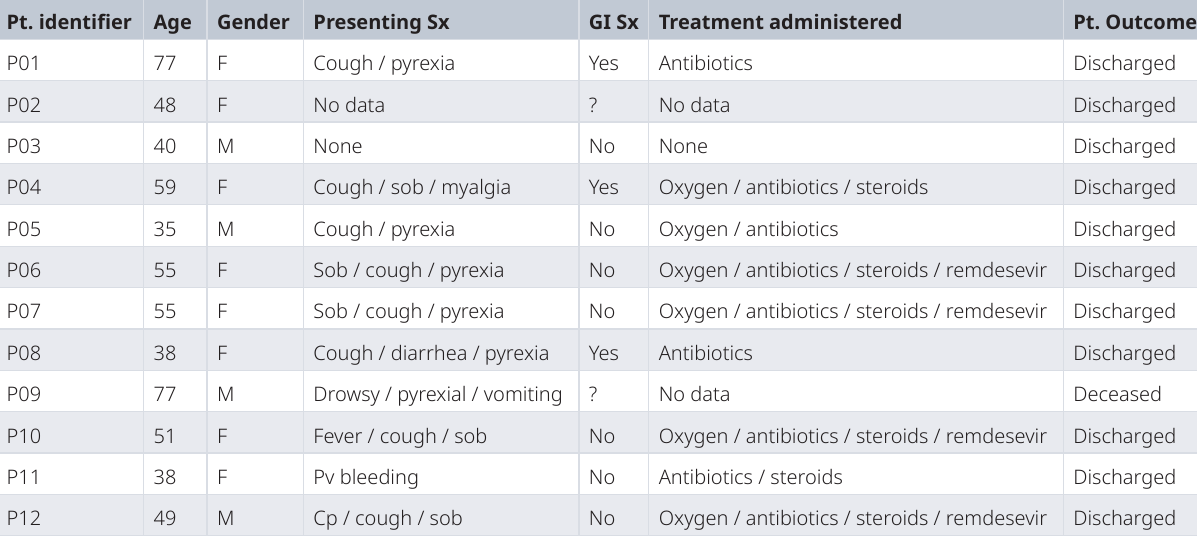
Table 1. Clinical data from 12 COVID-19 positive